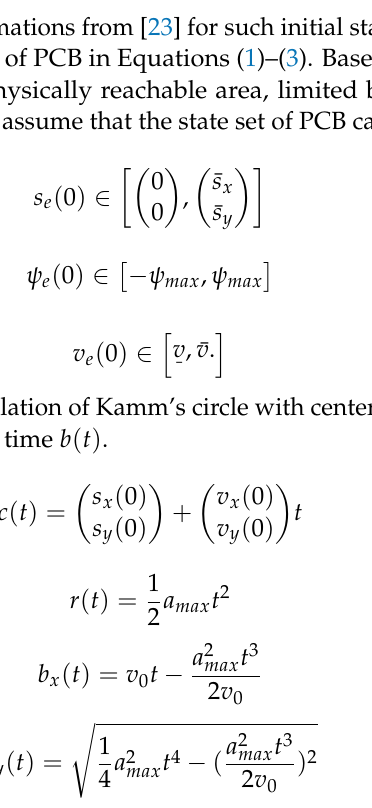
Figure 4. Notations for identifying the potential collision boundary.